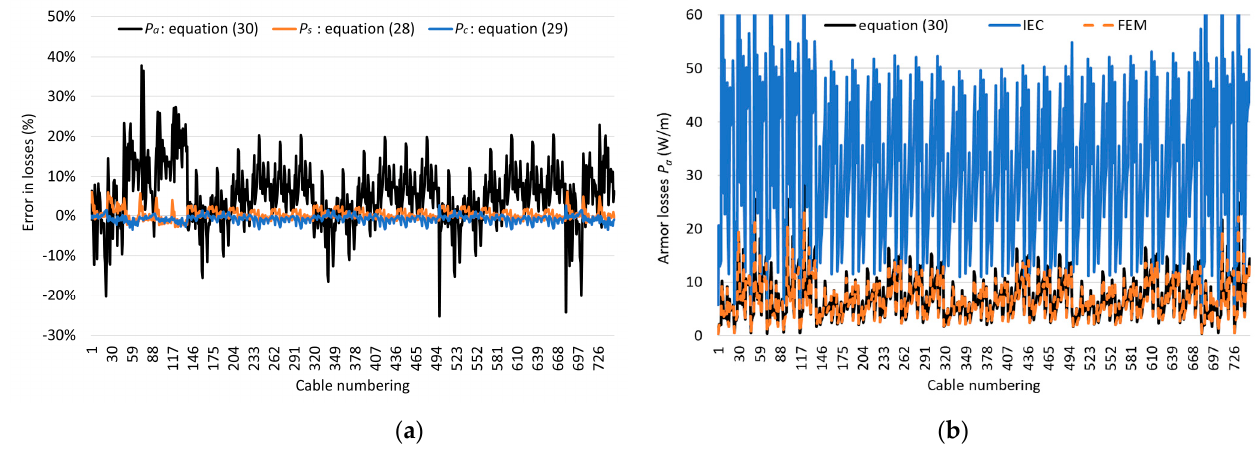
Figure 21. ( a ) Error, relative to FEM simulations, in the estimation of conductor, sheath and armor losses, and ( b ) armor